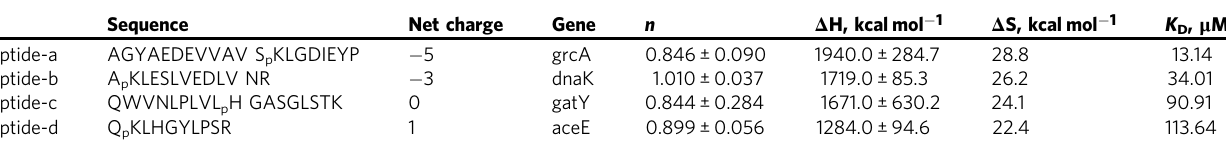
Table 1 Amino acid sequences of the N-phosphopeptides with different net charges and the stoichiometry ( n ), enthalpy ( Δ H , kcal/mol), entropy ( Δ S , kcal/mol), and dissociation constant ( K D , μ M) for the interactions with DpaZn.